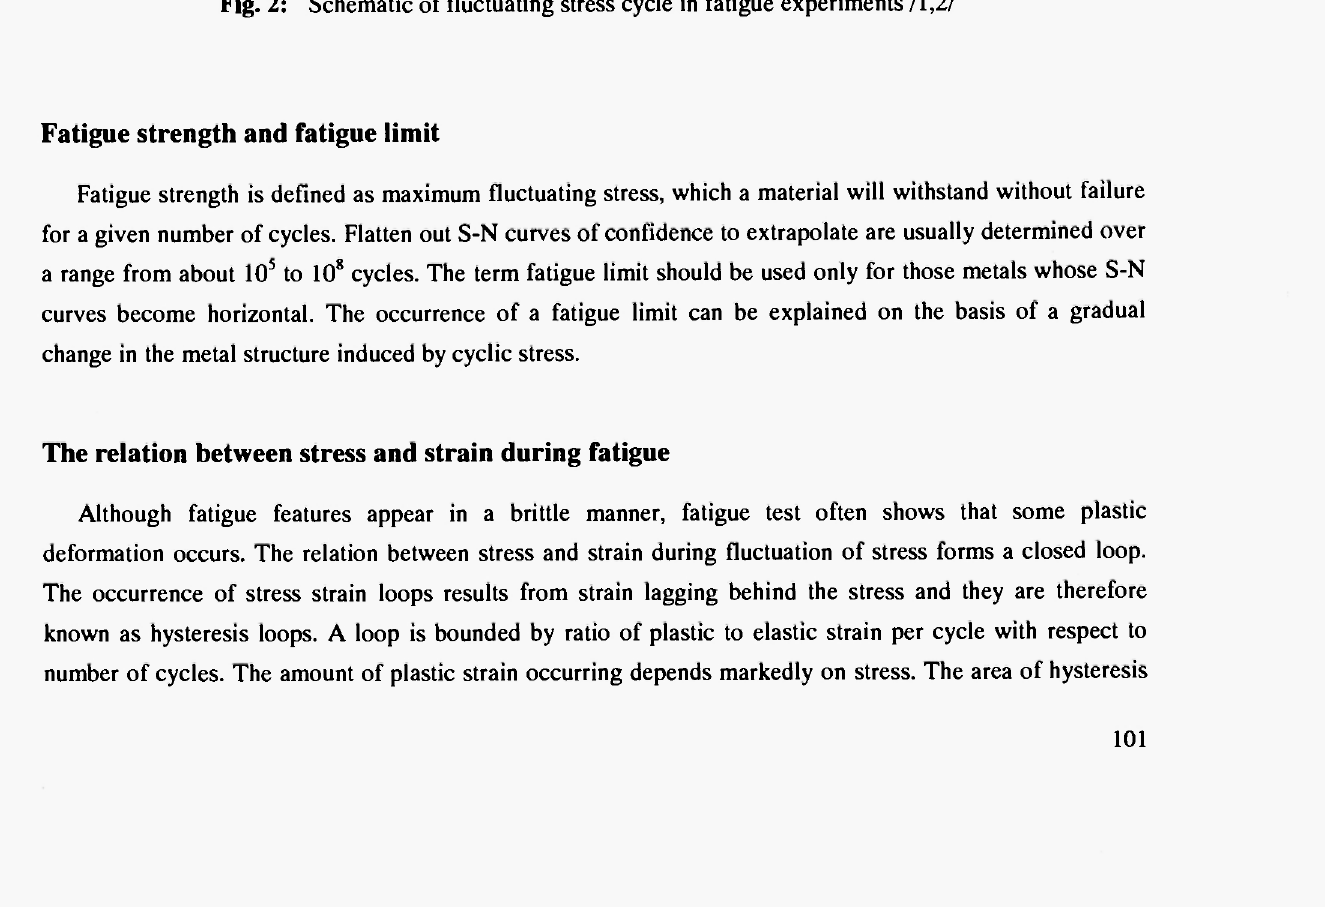
Schematic of fluctuating stress cycle in fatigue experiments